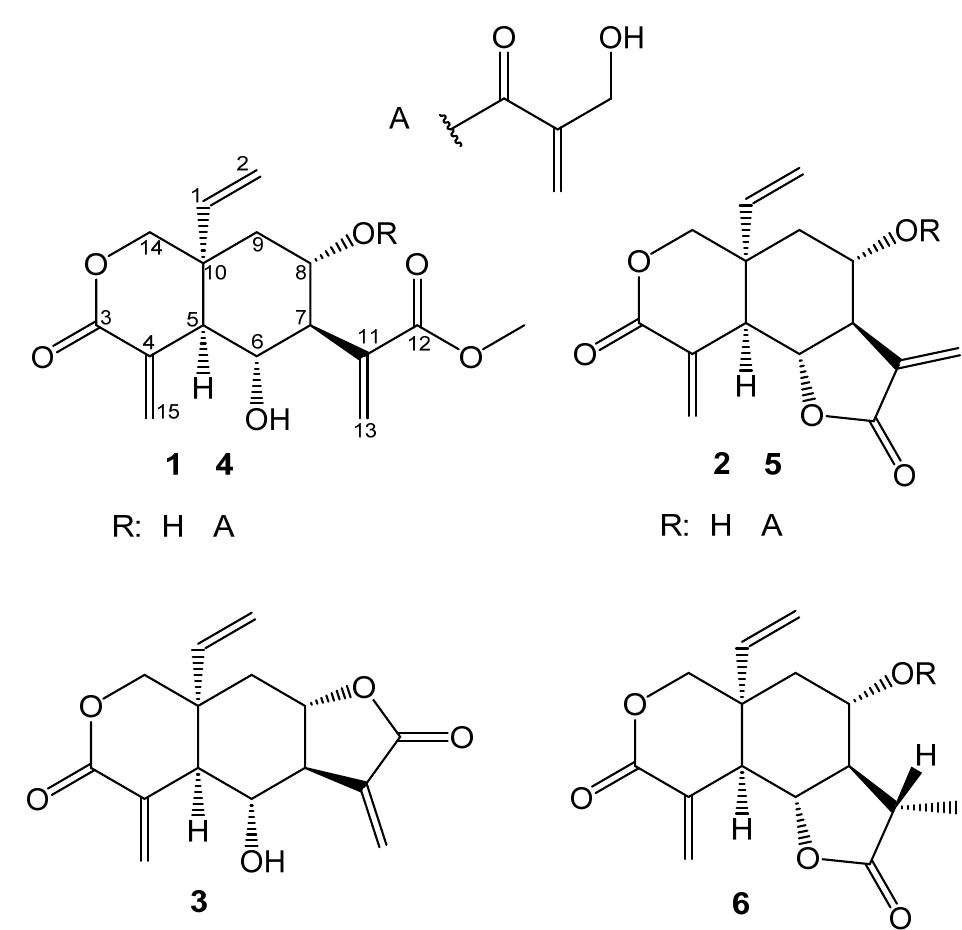
Figure 1. Elemanolide sesquiterpene lactones isolated from V. lasiopus . Table 3. In vitro anti-trypanosomal and cytotoxic IC 50 values in µ g/mL (values in µ M of pure compounds are reported in brackets) of elemanolides 1 – 6 . For positive controls, see Table